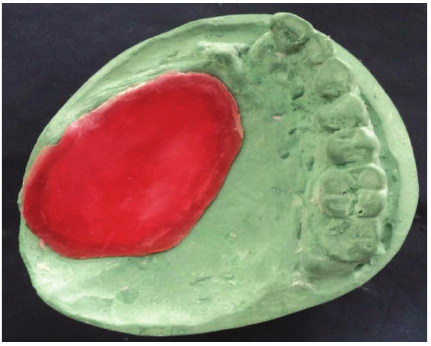
Figure 4: Sealed wax